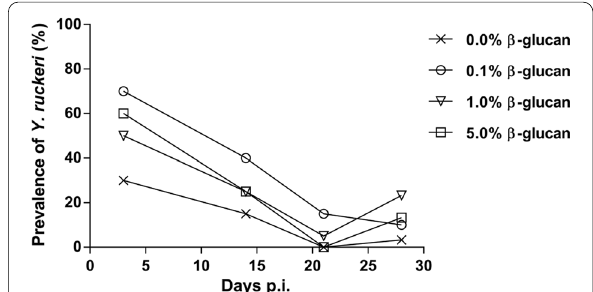
Fig. 5 Clearance of Y. ruckeri among experimentally infected fish shown as the prevalence of Y. ruckeri among the groups. Sampling size ( n ) was 10, 20, 20, 30 fish per group at 3, 14, 21, and 28 days p.i.,